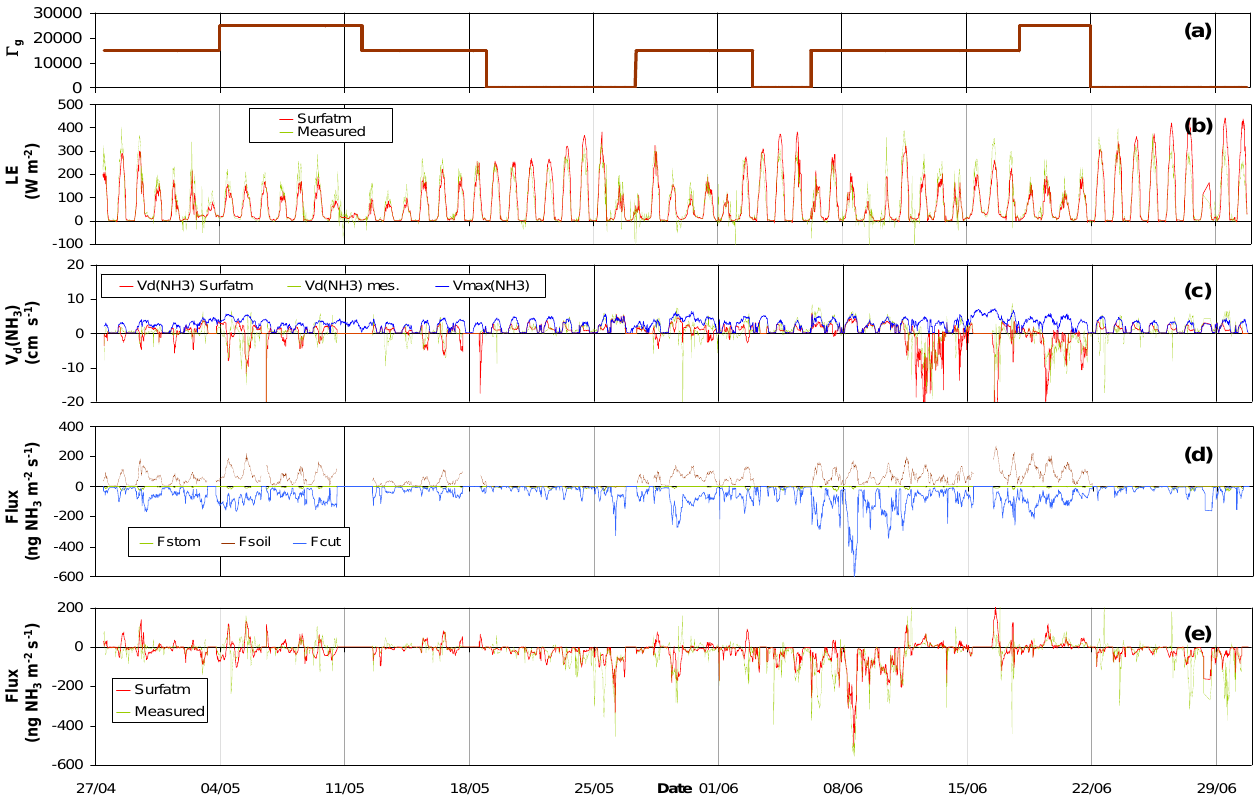
Fig. 9. From top to bottom: (a) soil NH 3 emission potential ( 0 g ), (b) comparison of simulated and measured latent heat fluxes (LE), (c) NH 3 deposition velocity ( V d ), (d) the fluxes form each compartment of the model (soil, stomatal, cuticular), (e) and the total NH 3 fluxes (Flux). For comparison the maximum deposition velocity is also given in the V d graph. Negative deposition velocities correspond to NH 3 emissions. In the simulations 0 s was set to zero while the 0 g was empirically set to the values given in the top graph. The 0 is the ratio [NH + the liquid phase of the given